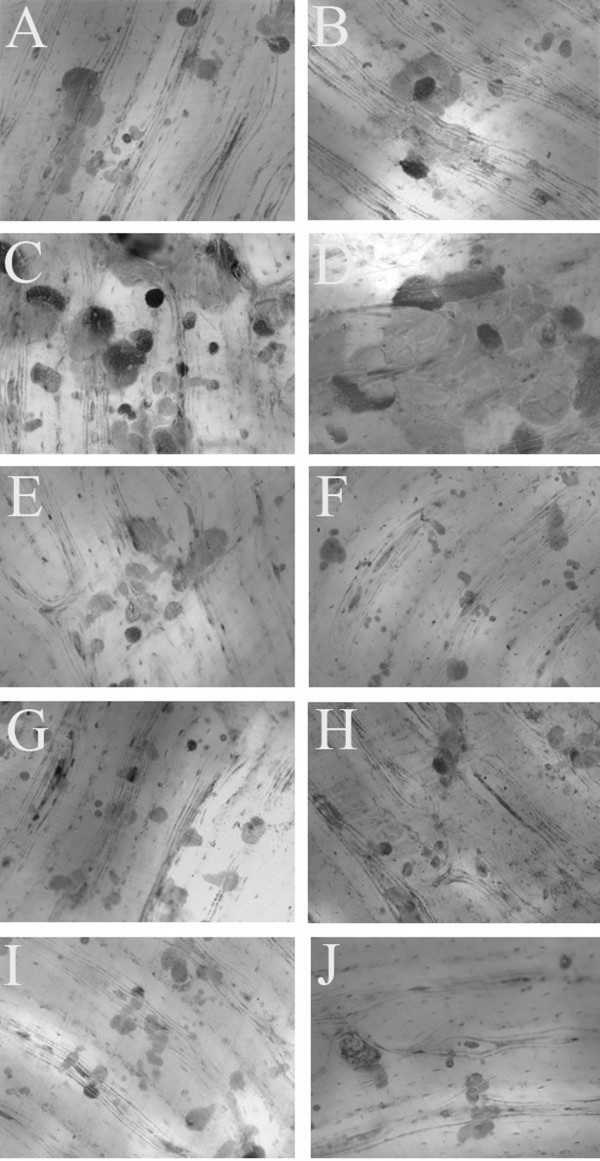
Typical appearance of the bone slices in the pit assay. Rat bone cells were cultured on bovine bone slices with different treatments. After 48 hours, cells were wiped off and resorbed bone area was visualized with image analyzer system. Bone slices after (A) Control (B) VEGF-A 10 ng/ml (C) VEGF-A 50 ng/ml (D) VEGF-A 100 ng/ml (E) Endostatin 0.02 μg/ml (F) Endostatin 0.2 μg/ml (G) Endostatin 2 μg/ml (H) VEGF-A 10 ng/ml and Endostatin 0.02 μg/ml (I) VEGF-A 50 ng/ml and Endostatin 0.2 μg/ml (J) VEGF-A 100 ng/ml and Endostatin 2 μg/ml treatments. Scale bar 100 μm.